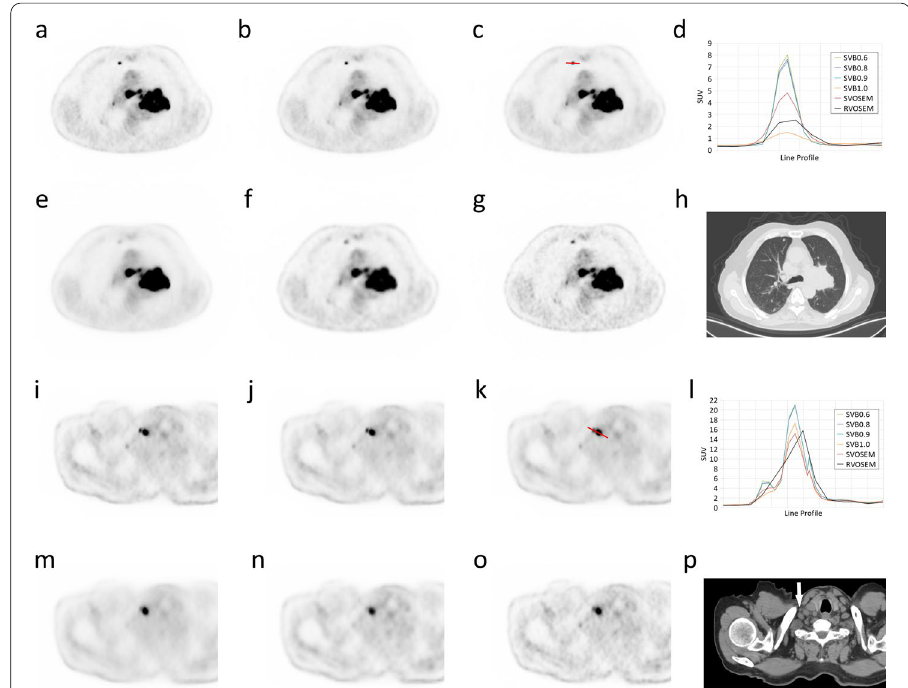
Fig. 4 An 83‑year man with lung cancer. The images of a lung nodule in the middle of the right lung next to the sternum were shown for SVB0.6 ( a ), SVB0.8 ( b ), SVB0.9 ( c ), SVB1.0 ( e ), RVOSEM ( f ), SVOSEM ( g ), and CT ( h ). The nodule has a diameter of 0.56 cm measured on CT axial view. The line profiles of the lung nodule were plotted on panel d for each reconstruction group. A red line was placed in panel c to illustrate the location where the line profile was generated. The lesion contrast was improved, and the image noise was similar in SVB0.8 and SVB0.9 groups compared to RVOSEM. Two 18 F‑FDG‑avid infraclavicular lymph nodes were identified on the same patient. The PET images were shown for SVB0.6 ( i ), SVB0.8 ( j ), SVB0.9 ( k ), and SVOSEM ( o ). The CT image reveals two round‑shaped soft tissue intensity nodes in the panel p. However, the node pointed by a white arrow was less appreciable on the images of SVB1.0 ( m ) and RVOSEM ( n ). The fusion views of PET/CT for the lymph nodes were provided in Additional file 1: Fig. 3 for SVB reconstructions. The line profiles of the lymph nodes for each reconstruction group were shown in panel l. The location of the line profile is illustrated in ( k ) (red